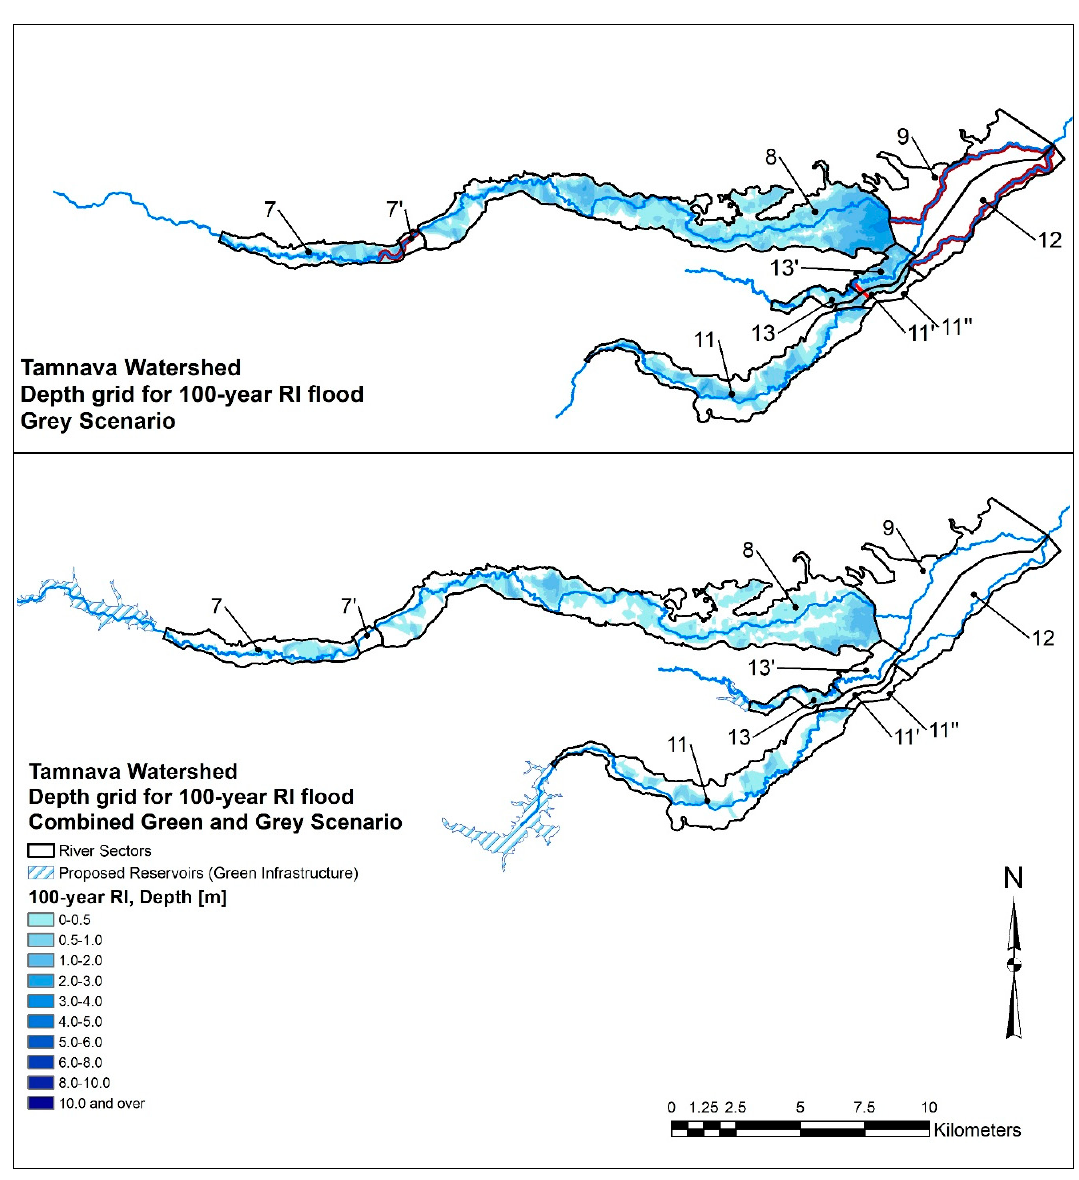
Figure 7. Effects of the three flood mitigation scenarios on flood hazard in the Tamnava watershed: green ( top ), grey ( mid ), and combined green-grey ( bottom panel). The figure shows hazard due to 100-year flood.